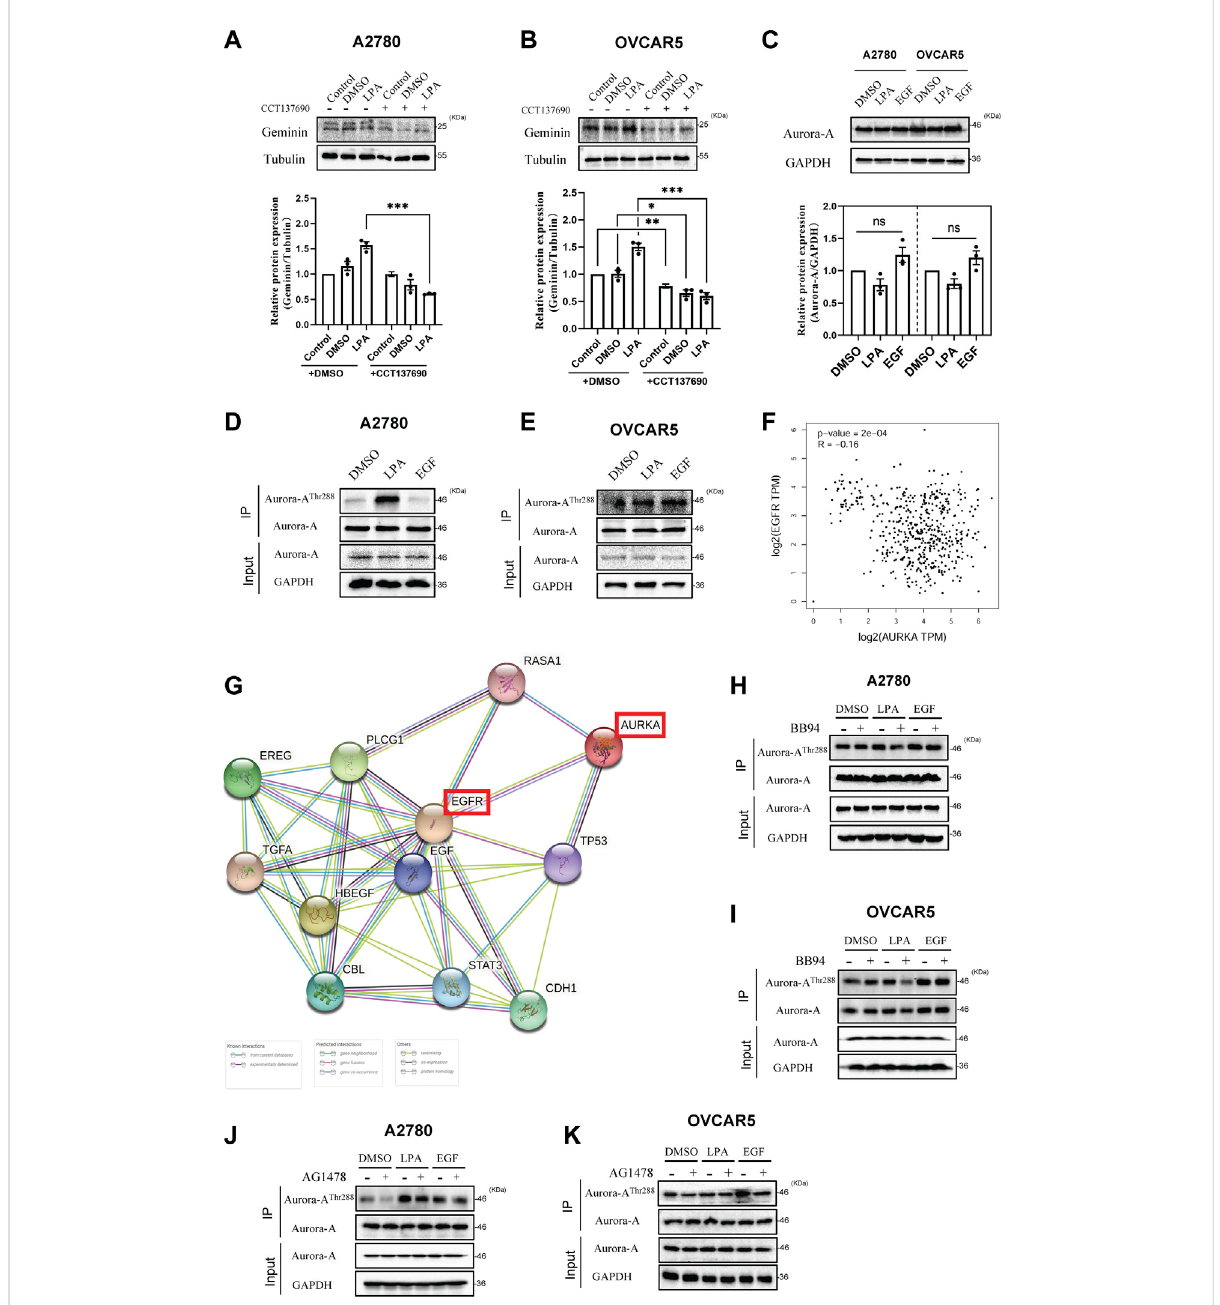
FIGURE 3 LPA potentiates geminin stability by targeting Aurora-A Thr288 in HGSOC cells. (A,B) Immunoblotting analysis of geminin protein levels in A2780 cells (A) and OVCAR5 cells (B) after pretreated with or without CCT137690 (25 μ M) for 120 min, and then stimulated with 0.1% DMSO (vehicle) or 10 μ M LPA. Mean ± SEM, n = 3, VNOVA, Dunnett ’ s Multiple Comparison Test, * p < 0.05, ** p < 0.01, *** p < 0.001. (C) IB analysis of Aurora-A protein levels in A2780 cells and OVCAR5 cells. Mean ± SEM, n = 3, VNOVA, Dunnett ’ s Multiple Comparison Test, ns, non-signi fi cant. (D,E) Immunoprecipitationanalysiswithanti-phospho-AuroraKinase(Thr288)antibodiesinA2780cells (D) andOVCAR5cells (E) treatedwith0.1%DMSO (vehicle), 10 μ M LPA or 10 ng/mL EGF for 5 min (A2780 cells) or 30 min (OVCAR5 cells). (F) Correlation of gene AURKA and EGFR in TCGA ovarian cancer cohort. log2 fold changes of gene expression on the axis, and the Spearman Method was used for calculating the correlation coef fi cient. (G) The protein-protein associations between Aurora-A and EGFR protein. Data from STRING. (H – K) IP analysis with anti-phospho-Aurora Kinase (Thr288) antibodies in A2780 cells (H,J) and OVCAR5 cells (I,K) after pretreated with or without 10 μ M BB94 (H,I) or 10 μ M AG1478 (J,K) for 30 min, then treated with 0.1% DMSO (vehicle), 10 μ M LPA or 10 ng/mL EGF for 5 min (A2780 cells) or 30 min (OVCAR5